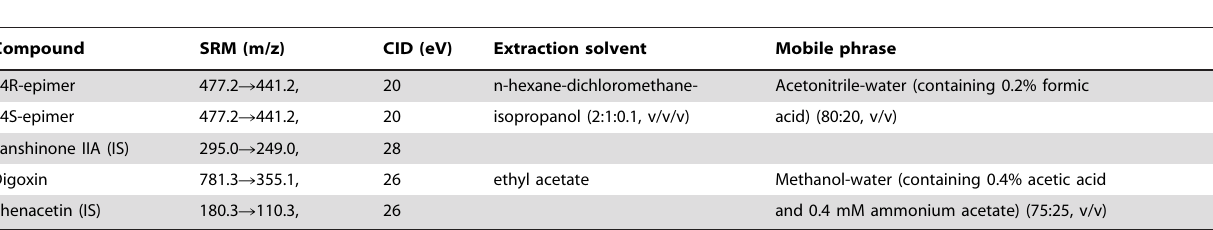
Table 1. Analytical conditions in LC-MS/MS analysis of 24R-epimer, 24S-epimer and digoxin.